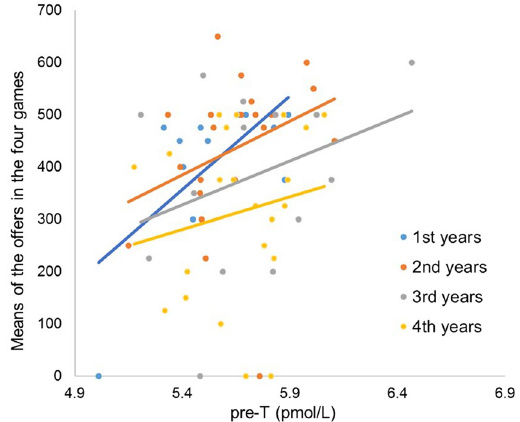
Figure 2. The relationship between baseline testosterone level and the mean of the offers in the four games for each seniority level. Spearman’s correlation coefficient: first years ( r s = 0.50, p = 0.09), second years ( r s = 0.45, p = 0.04), third years ( r s = 0.28, p = 0.32), fourth years ( r s = 0.18, p =